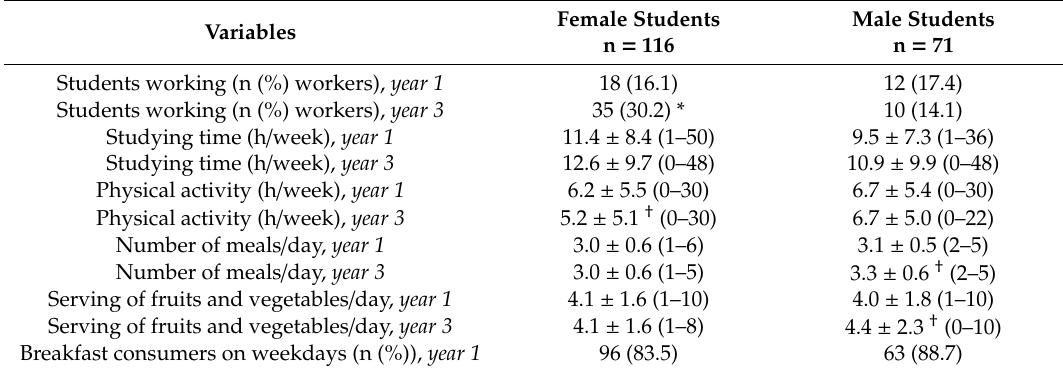
Table 1. Working, studying, physical activity, and eating habits of high school female and male students.